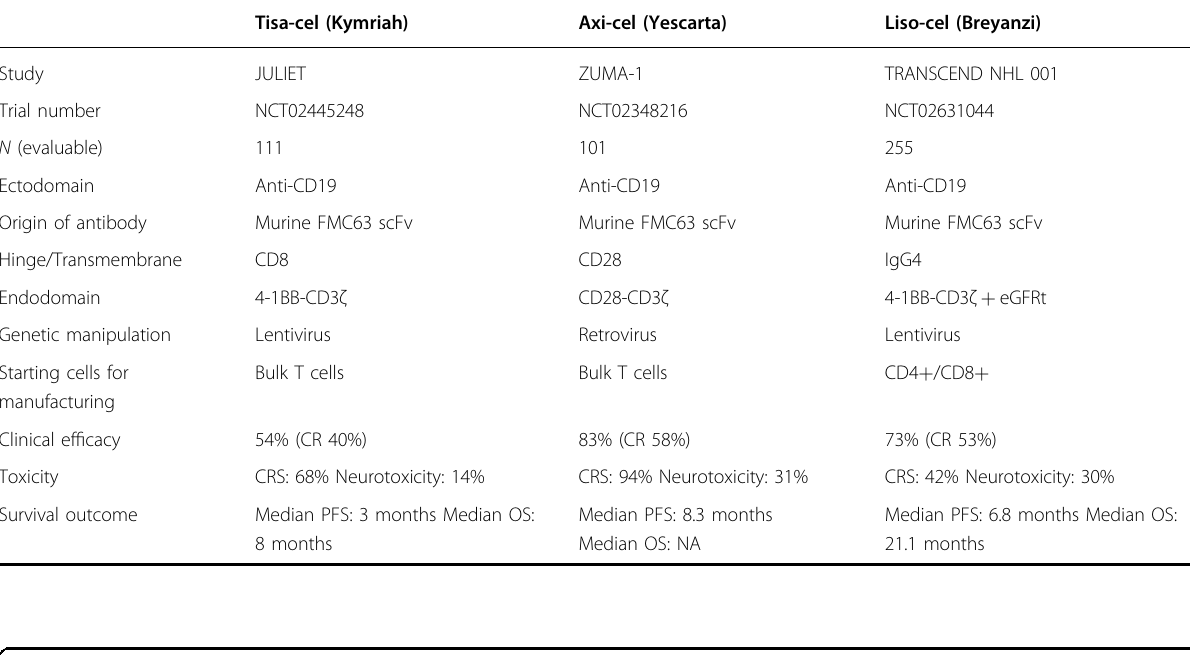
Table 1 FDA-approved anti-CD19 CAR T-cell therapies (true to the time of writing).